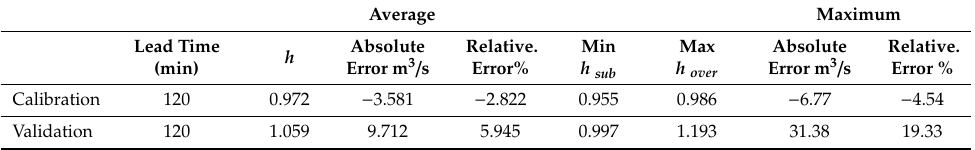
Table 4. Error statistics estimated over a selected family of peak flows in both samples.